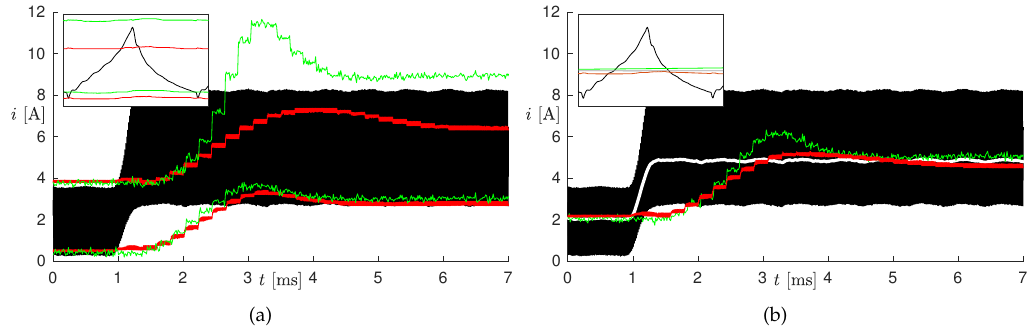
Figure 10. Inductor current on Test #2 with nonlinear (green curves) and constant (red curves) inductance. The black curve is the measured current and the gray curve in panel ( b ) its mean value over each PWM period. The green (red) curves in panel ( a ) are the minimum and maximum currents estimated with the nonlinear (constant) inductance. Panel ( b ) shows instead the mean estimated